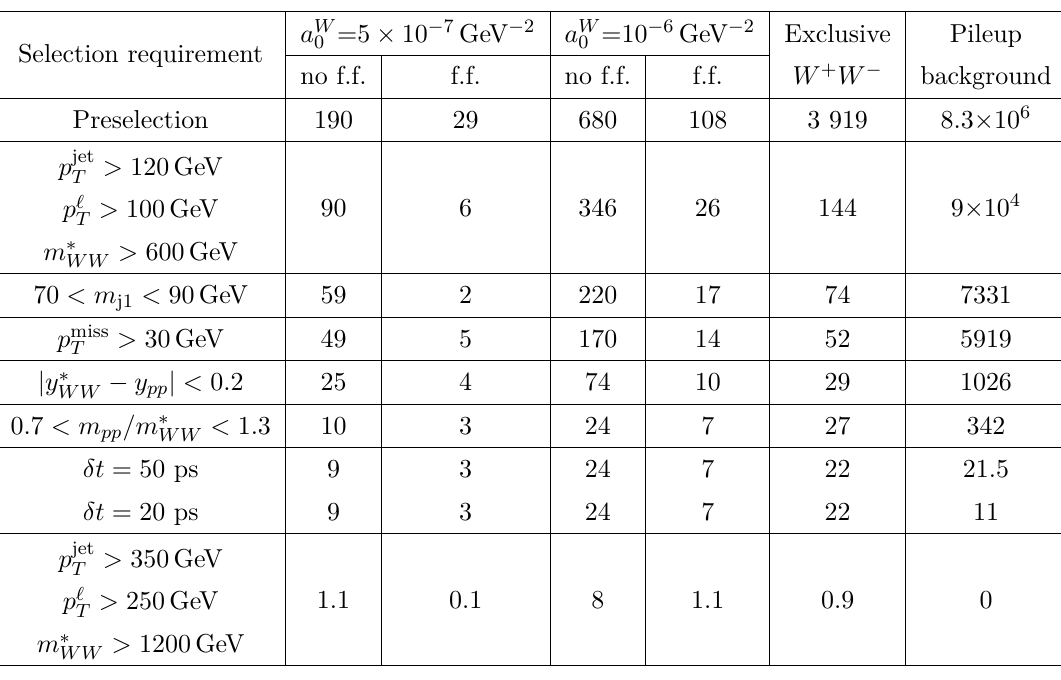
Table 5 . Number of events for an integrated luminosity of 300 fb − 1 after each selection criterion in the search of anomalous exclusive W + W − boson pair production with and without form factors ( a W = 5 × 10 − 7 GeV − 2 and a W = 10 − 6 GeV − 2 with a W = 0 in semi-leptonic channel. The second-to- 0 0 C last column corresponds to SM exclusive W + W − boson production, and the pileup background, which includes the combination of the pileup backgrounds. The bottom row corresponds to the selection requirements optimized for the anomalous coupling studies, as described in the text. at 95% CL by applying a similar cut on the N -subjettiness ratio τ /τ < 0 . 5 , as 2 1